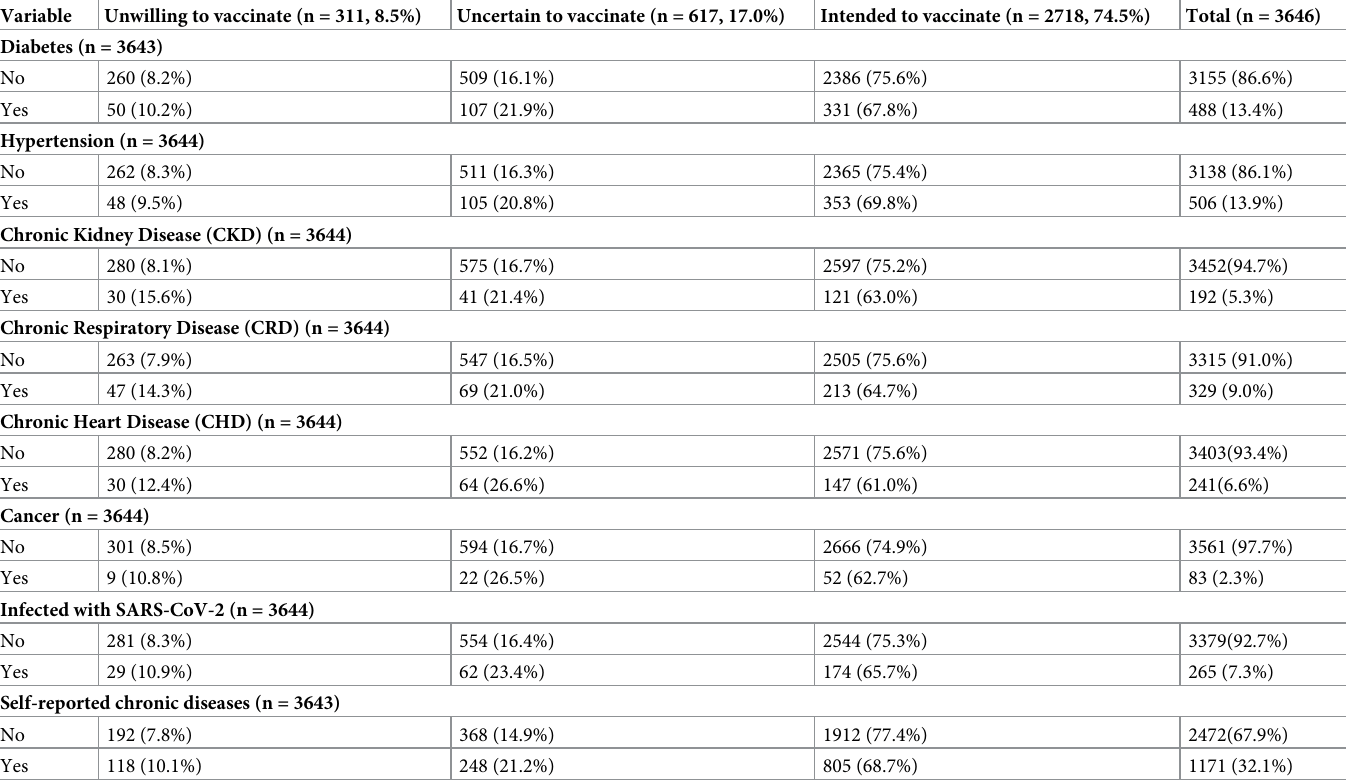
Table 2. Distribution of vaccine acceptance, hesitancy, and unwillingness by COVID-19 infection and self-reported chronic conditions.